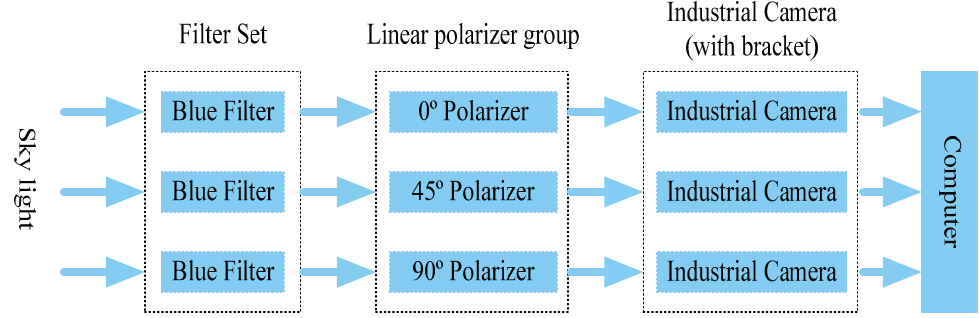
Figure 3. The configuration of the